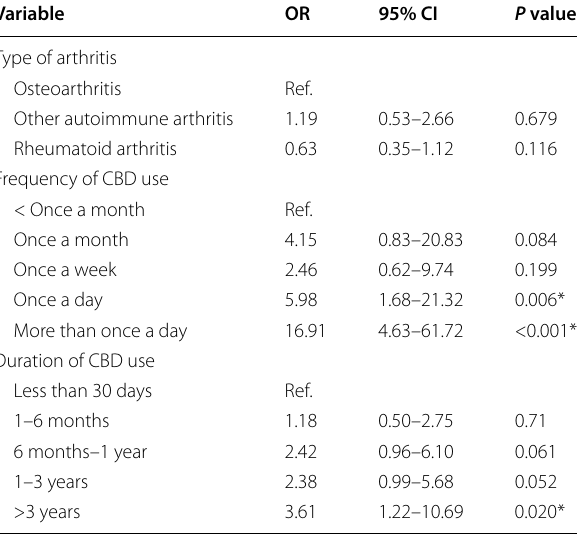
Logistical regression model controlled for age, gender, and ethnicity as covariates CBD cannabidiol, OR odds ratio, CI confidence interval, % percent, Ref.